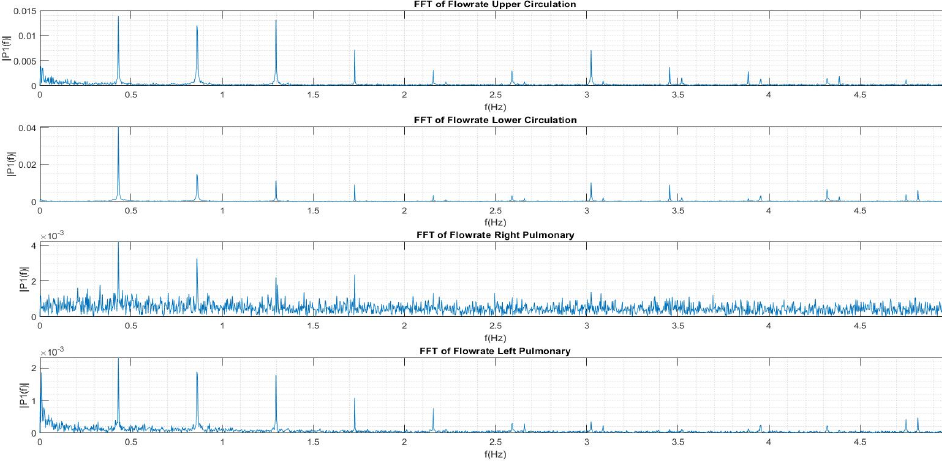
Figure A1. FFT on flow waveform for 3 mm IJS at a proximal anastomotic angle of 5 degree.